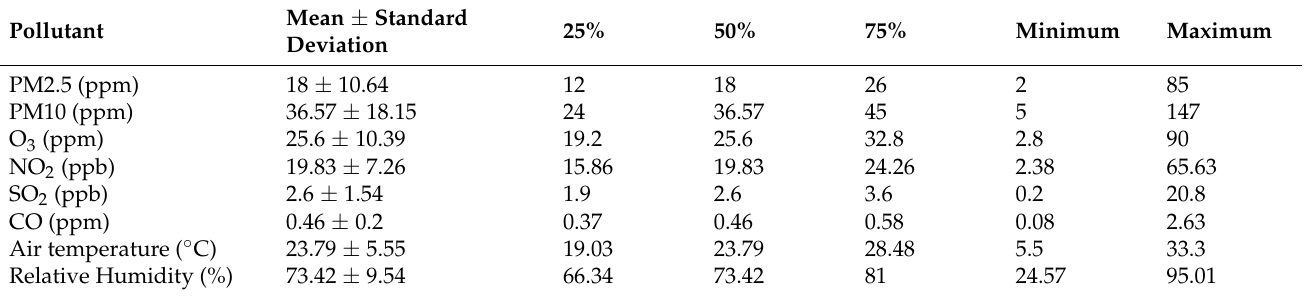
Table 1. Air pollutants and meteorological factors recorded at the Songshan air quality station over 9 years (2011–2019).